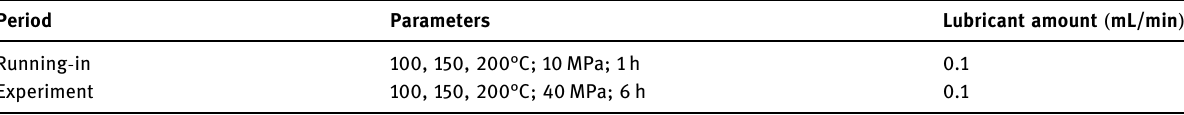
Table 1: The parameters of the wear test Period Parameters Running - in Experiment